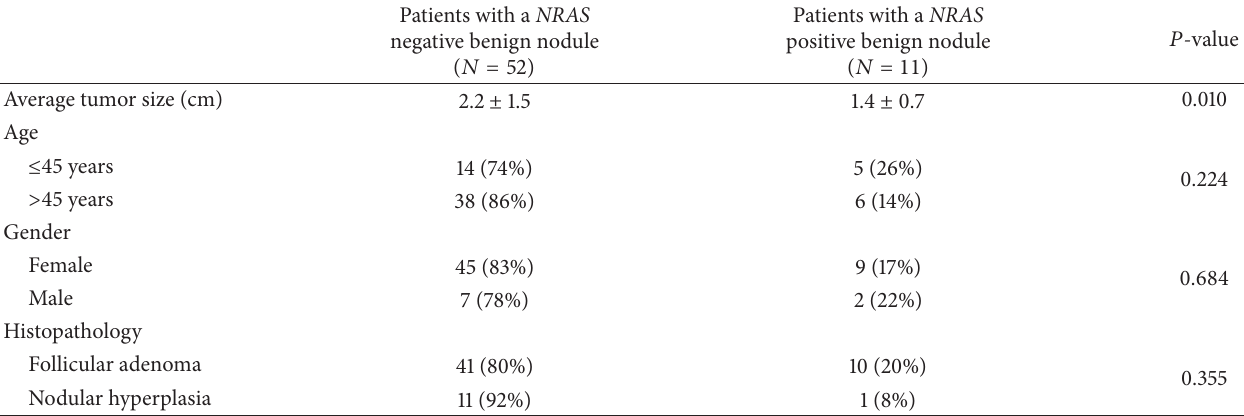
Table 3: Clinicopathologic features and the NRAS mutation status of 63 benign lesions with a preoperative diagnosis of follicular neoplasm. Patients with a